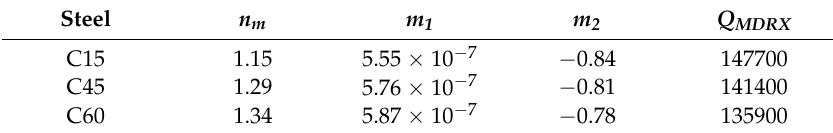
Table 6. Model coefficients for metadynamic recrystallization.